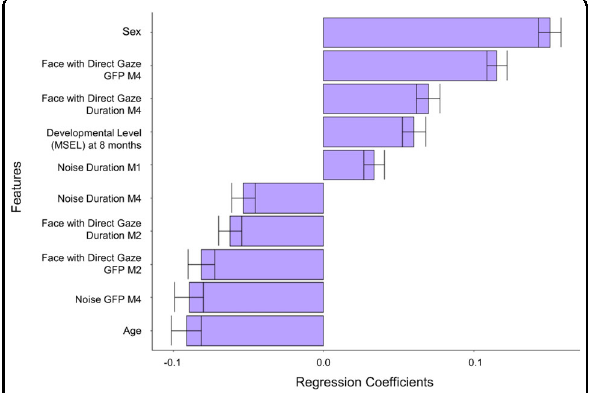
Fig. 5 Individual prediction of dimensional variation in social skills. Regression coef fi cients for prediction of VABS Socialization score at 3 years at an individual level are displayed on the x -axis, using demographic data (sex, age in days, developmental level as measured by the MSEL Early Learning Composite score at 8 months) and microstate features in response to faces with direct or averted gaze, and Noise. Microstate features included duration and global fi eld power (GFP) of microstates 1 (M1), 2 (M2) and 4 (M4). Only coef fi cients that were always selected by the elastic-net regression model with leave-one-out cross-validation are reported. Bars indicate the average of regression coef fi cients over cross-validation folds is shown, and error bars indicate the standard deviation. Coef fi cients are in standard